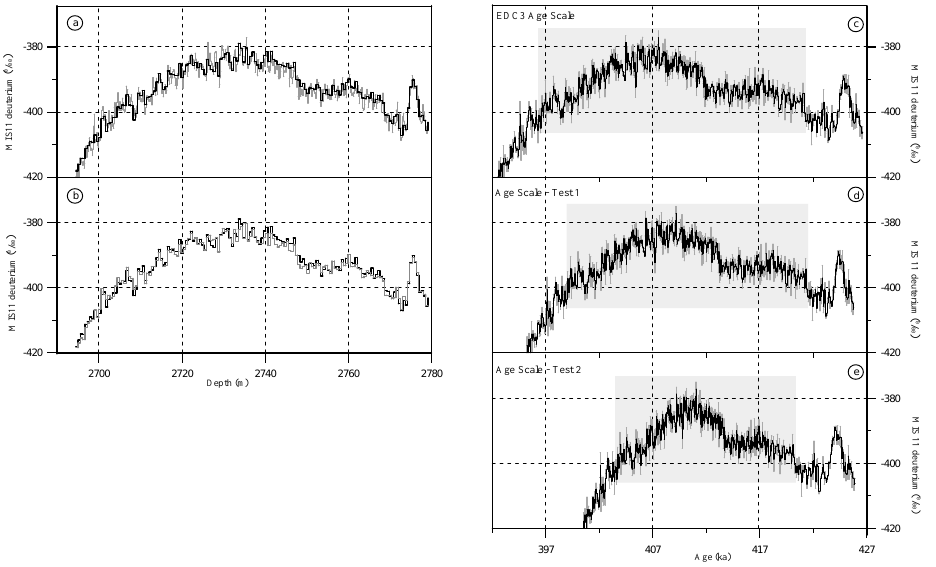
Fig. 1. Summary of the available EDC δD (‰) data for MIS 11 first plotted for the function of depth (panels a and b, in m) and then for the function of time (panels c to e, in ka). (a) δD from MIS 11 bag samples (black) and the new high-resolution δD signal from the fine samples (grey). (b) MIS 11 δD bag samples (black) in comparison with the mean signal (grey) obtained from the average of 5 fine cuts. (c) High-resolution δD data (black) plotted with respect to the official EDC chronology (EDC3, Parrenin et al., 2007) and corrected from the isotopic diffusion (grey). Panels (d) and (e) display the same signals using two other age-scales (Sect. 5.3) (Test 1 and Test 2 respectively) for sensitivity tests on MIS 11